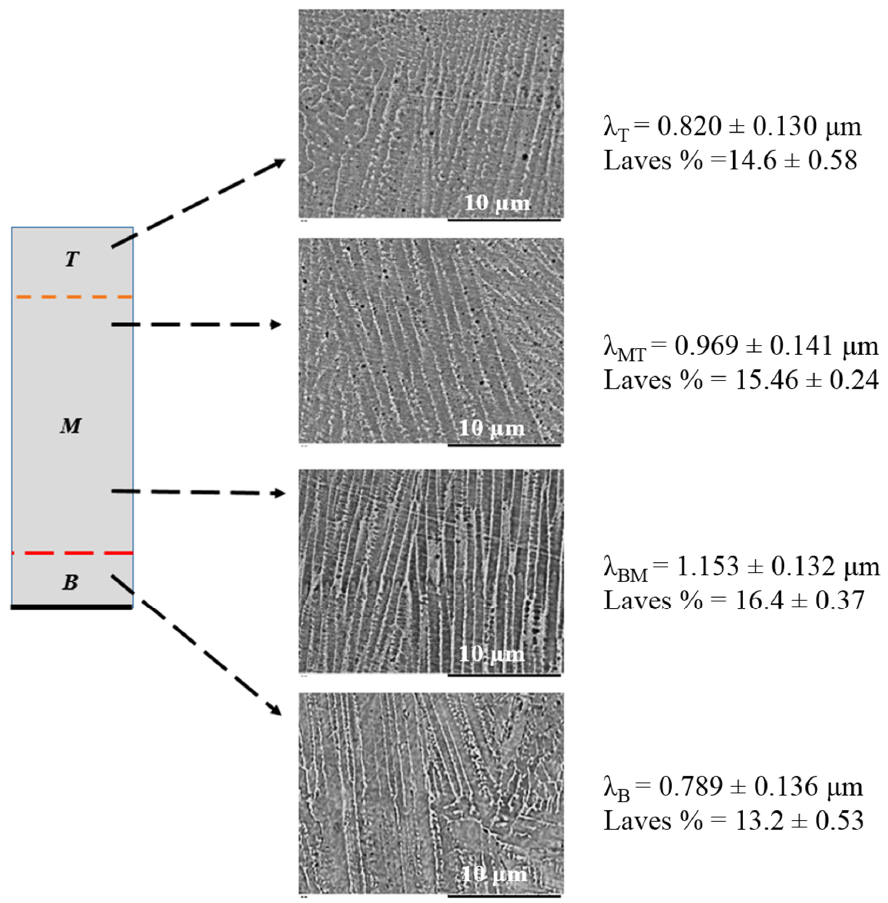
Figure 4. Variation of DAS and Laves fraction along the as-SLM IN718 specimen height. The BM to MT area is the middle region between the bottom (B) and the top (T) of the examined samples.